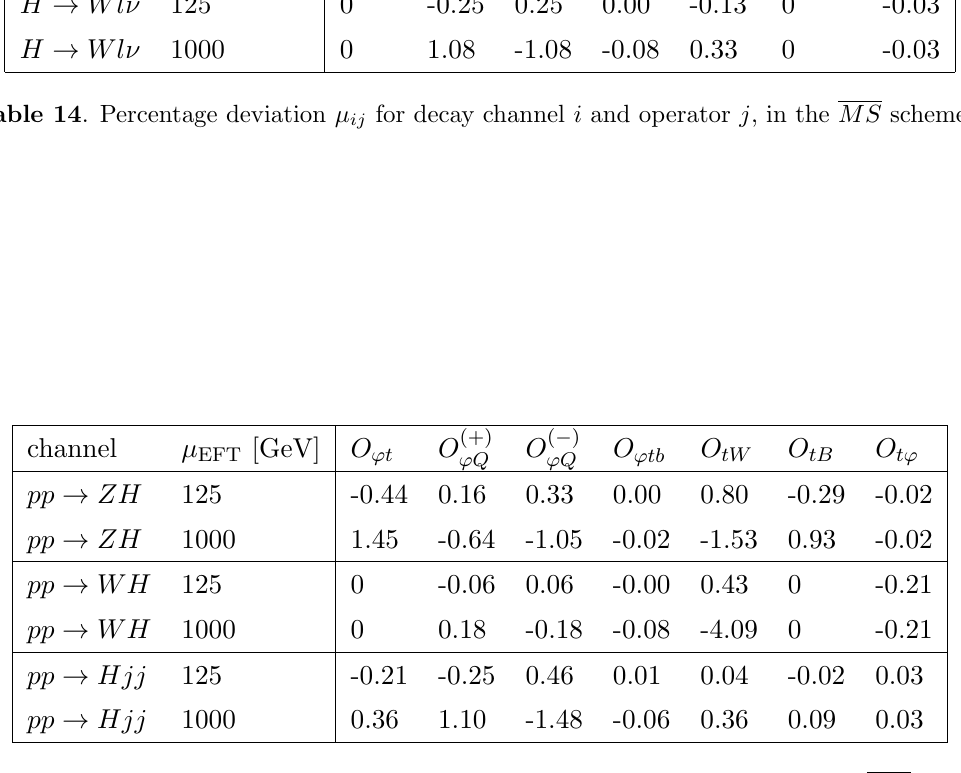
Table 15 . Percentage deviation (cid:22) ij for production channel i and operator j , in the MS